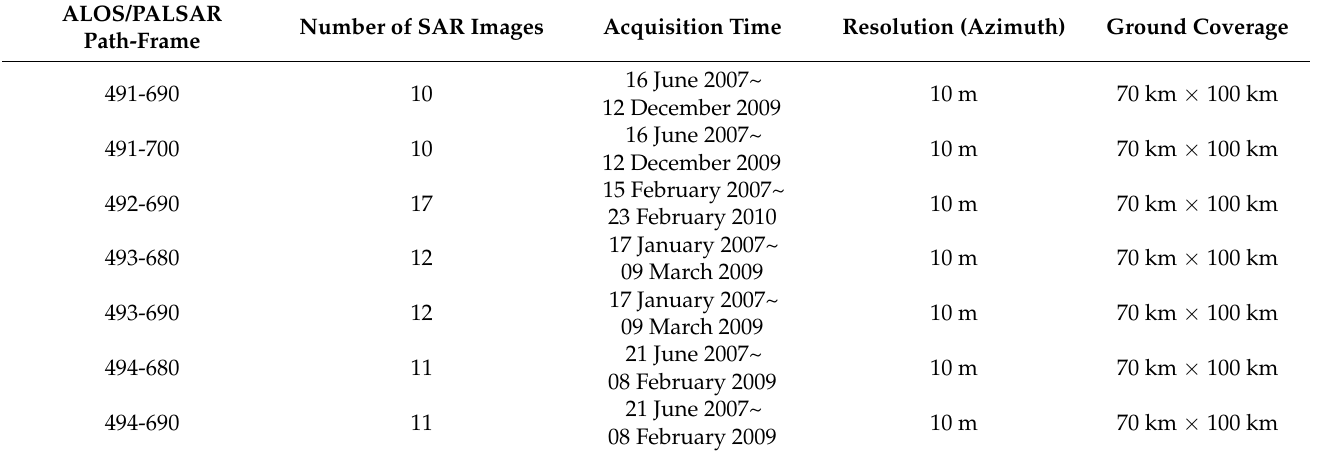
Table 1. ALOS/PALSAR Data.